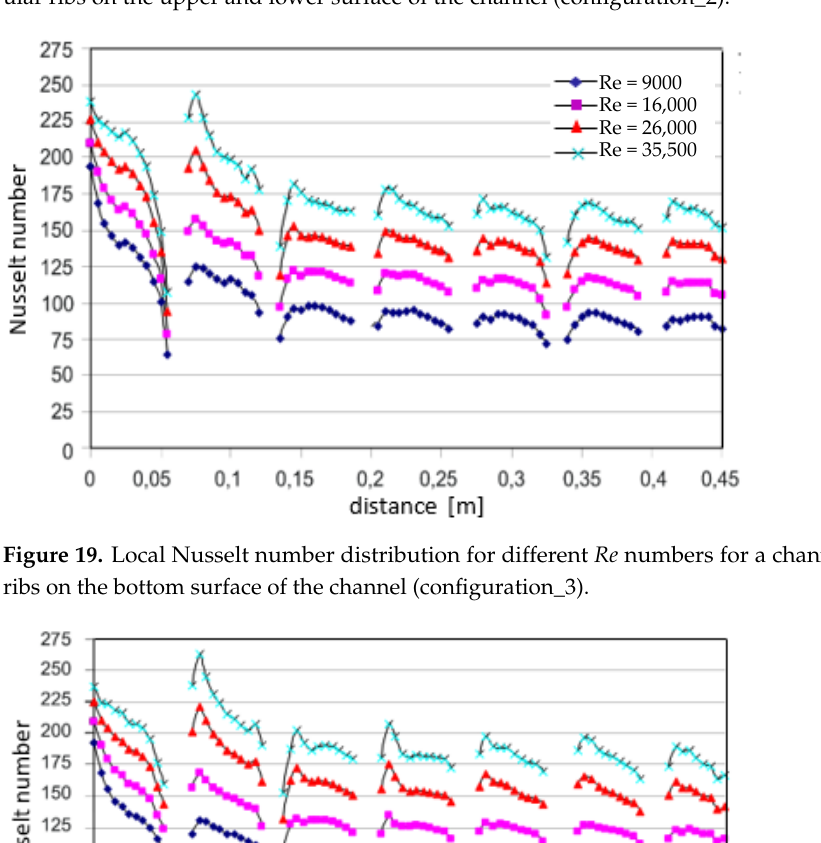
Figure 18. Local Nusselt number distribution for different Re numbers for a channel with perpendicular ribs on the upper and lower surface of the channel (configuration_2).